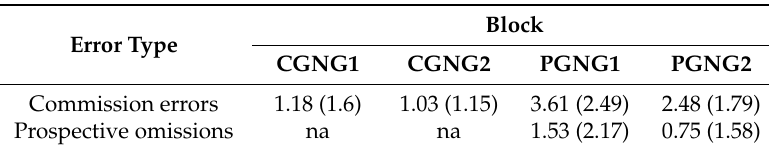
Table 1. Means and standard deviations ( M, SD ) for commission errors and prospective omissions in blocks 1 and 2 of CGNG and